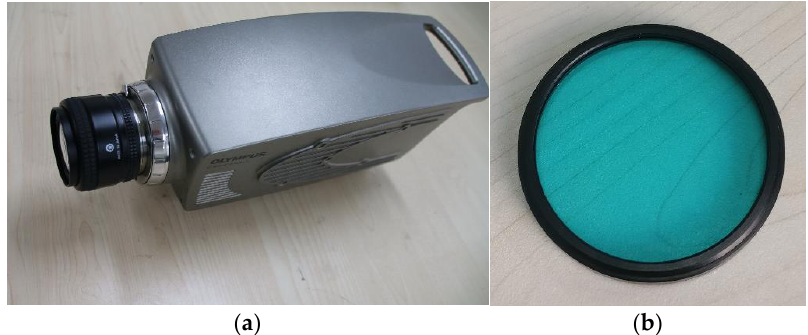
Figure 4. Flame zone recording instruments: ( a ) high-speed camera; ( b ) optical filter.